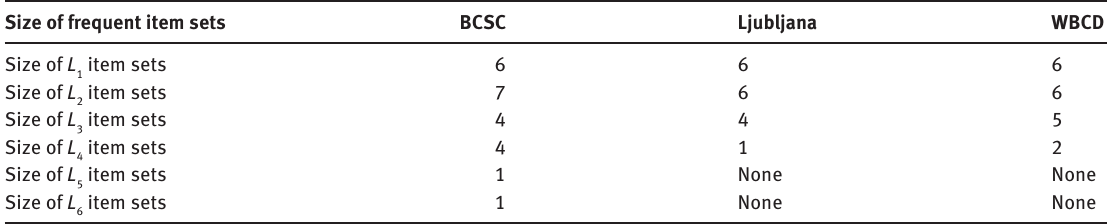
Table 2: Frequent Item Sets Generated for All Three Breast Cancer Data Sets Used for Feature Selection.